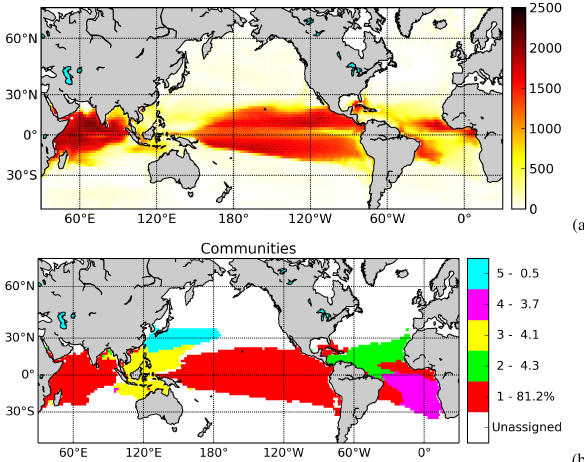
Fig. 9: (a) Degree centrality of the ESM-SST-LP8y network. The network was built using the Fig. 9. (a) Degree centrality of the ESM-SST-LP8y network. The Fig. 8: (a) Degree centrality of the ESM-SST network. The network was built using the same Fig. 8. (a) Degree centrality of the ESM-SST network. The network network was built using the same methodology as for the H-SST- was built using the same methodology as for the H-SST network but same methodology as for the H-SST-LP8y network but using SST from the MPI-ESM-LR historical methodology as for the H-SST network but using SST from the MPI-ESM-LR historical simulations. LP8y network but using SST from the MPI-ESM-LR historical sim- using SST from the MPI-ESM-LR historical simulations. A thresh- simulations. A threshold of τ =0 . 6 was used as for the H-SST network leading to an edge density A threshold τ =0 . 4 was used as for the H-SST network leading to an edge density ρ =0 . 073 . (b) ulations. A threshold of τ = 0 . 6 was used as for the H-SST network old τ = 0 . 4 was used as for the H-SST network leading to an edge ρ =0 . 077 . (b) Filtered communities in the ESM-SST-LP8y network. Filtered communities in the ESM-SST network. leading to an edge density ρ = 0 . 077. (b) Filtered communities in density ρ = 0 . 073. (b) Filtered communities in the ESM-SST net- the ESM-SST-LP8y work.